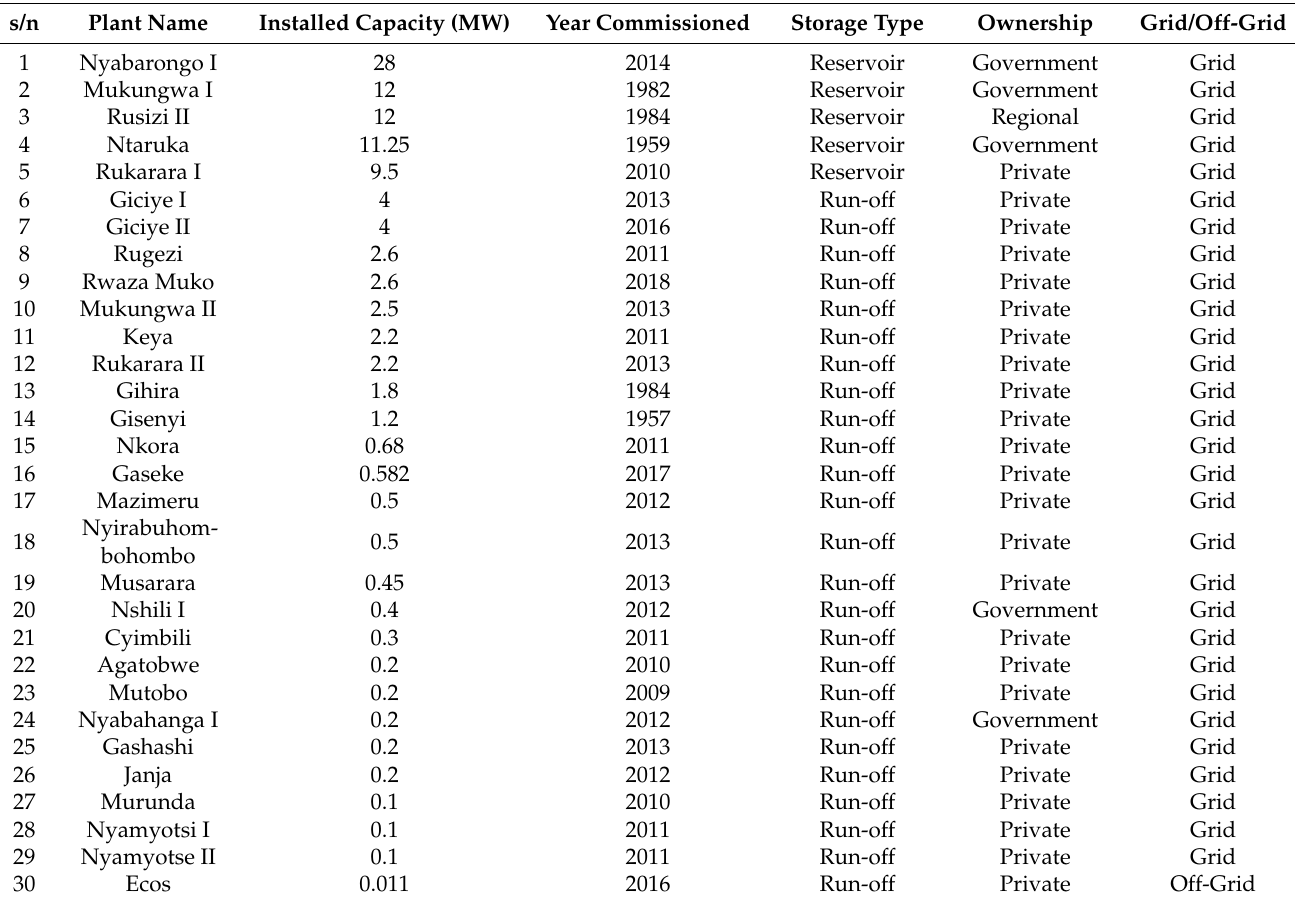
Table 1. Characteristics of deployed hydropower plants in Rwanda for both small and big